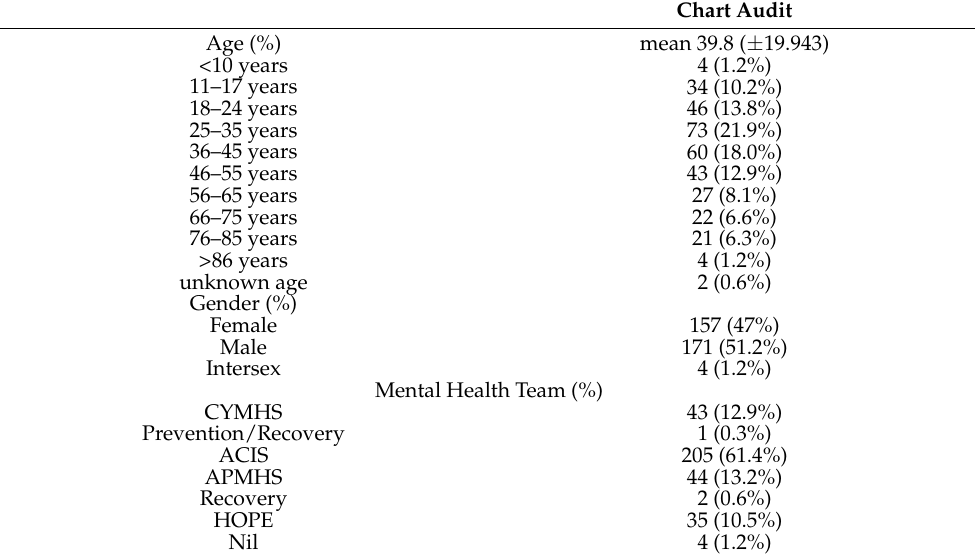
Table 1. Chart audit